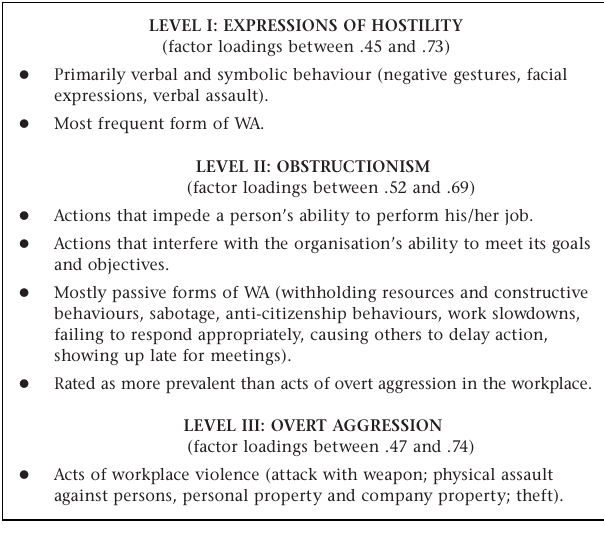
Figure 1: Three-factor model of workplace aggression